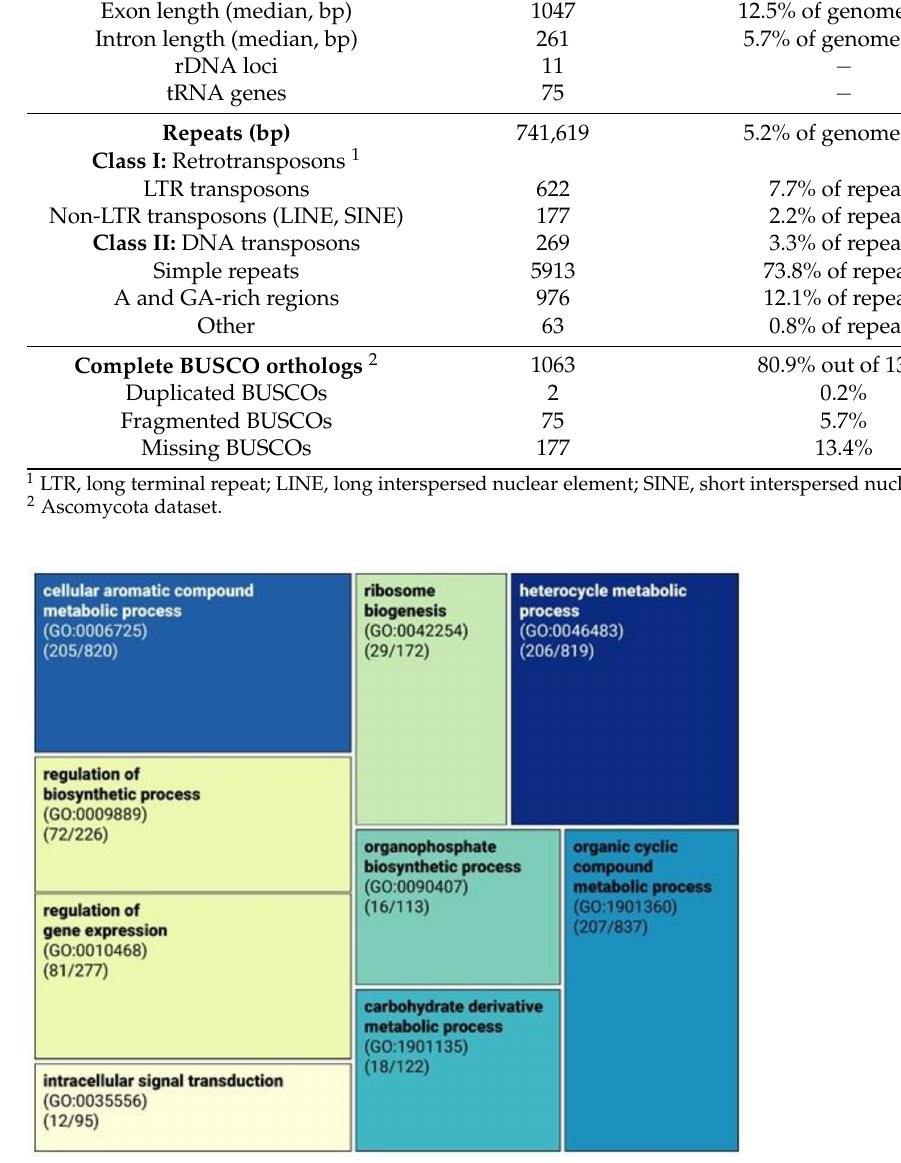
Figure 3. Significantly overrepresented slim gene ontology (GO) terms for biological processes of genes absent in Novakomyces olei sp. nov. compared to the reference gene set of Schizosaccharomyces pombe as its close relative. The sizes of the rectangles are proportional to the percentage of missing genes in a GO